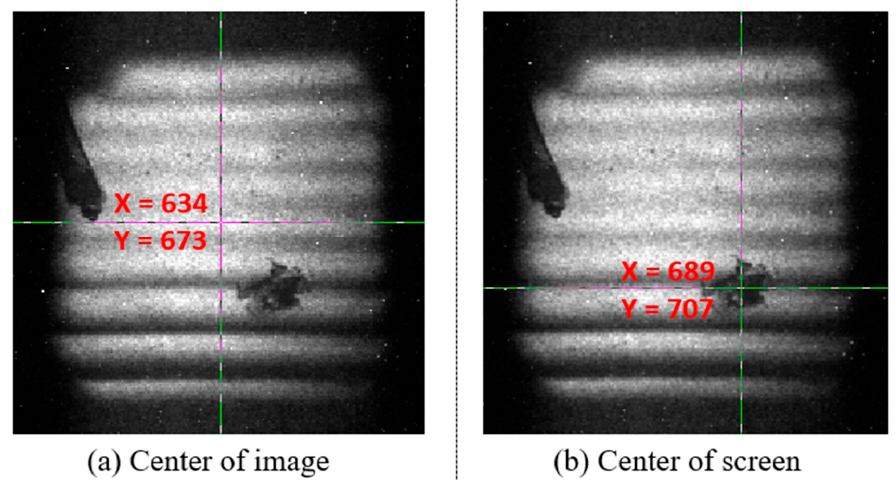
Figure 6. Measurement results of the beam waist offset: ( a ) center of image; ( b ) center of screen. (The values of X and Y in the figure correspond to the pixel coordinates of the position represented by the green cross in the image from the CCD).